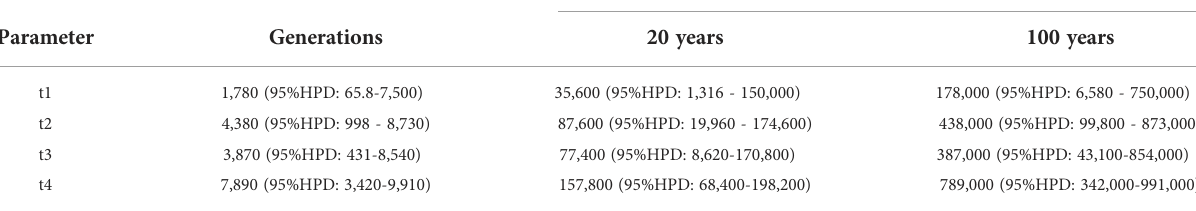
TABLE 3 Demographic parameters of Scenario 5 obtained by